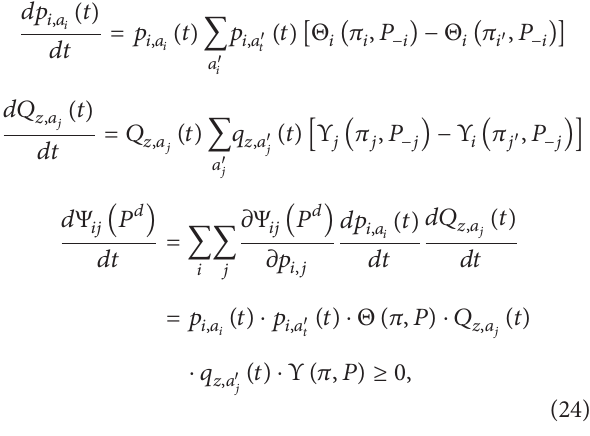
Figure 3: (a) The throughput related to the new topology for coordinator attacks. (b) The delay related to the new topology for coordinator